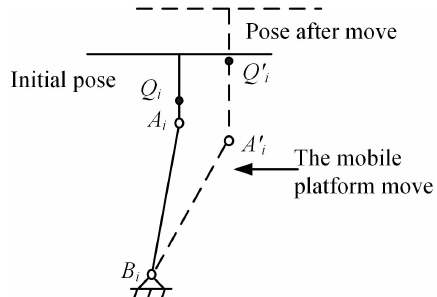
Figure 7. Sketch of micromotion.